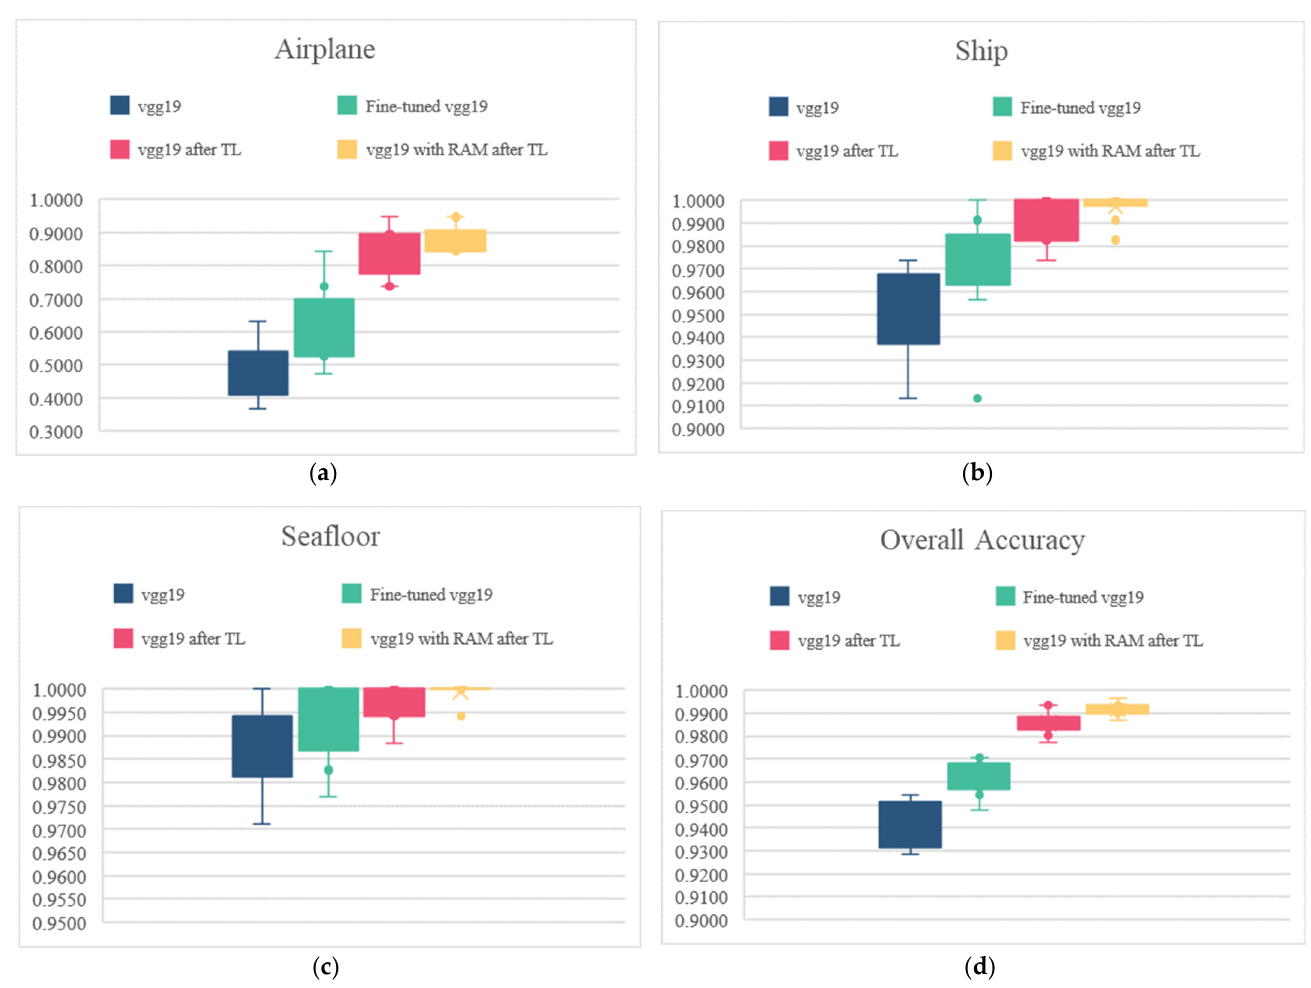
Figure 9. Box plots of the precision of each category and overall accuracy using different methods: ( a ) Classification precision of airplane; ( b ) Classification precision of ship; ( c ) Classification precision of seafloor; ( d ) Overall accuracy.